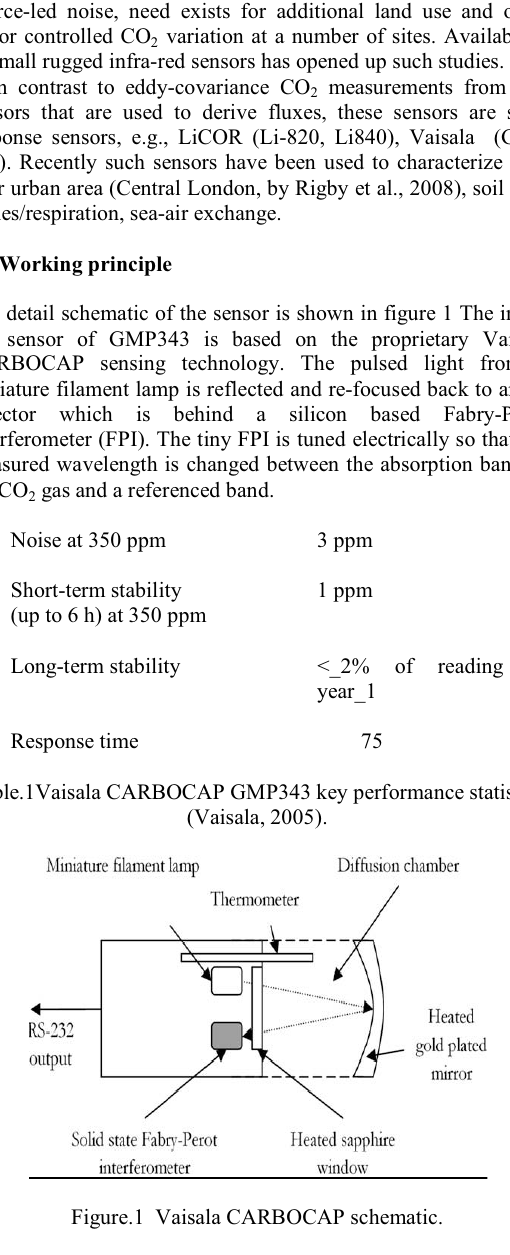
stability ( Table 1: Key specifications of GMP343). The measurement is based on the advanced CARBOCAP Single – Beam –Wavelength NDIR technology. Rigby, (2008) reported the reliable results of continuous measurement of CO 2 using GMP343 at Central London.